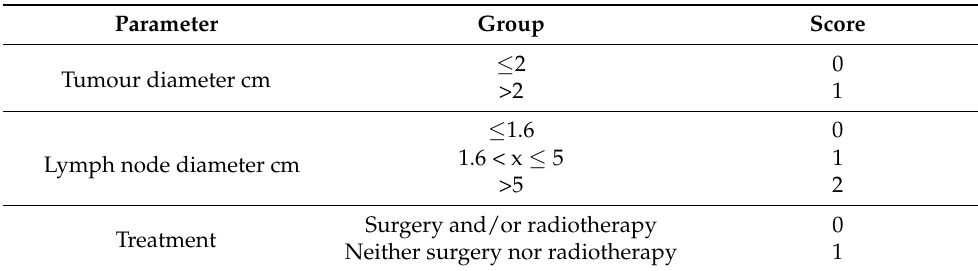
Table 4. Algorithm to predict survival time for dogs with AGASAC based on staging data and proposed treatment.